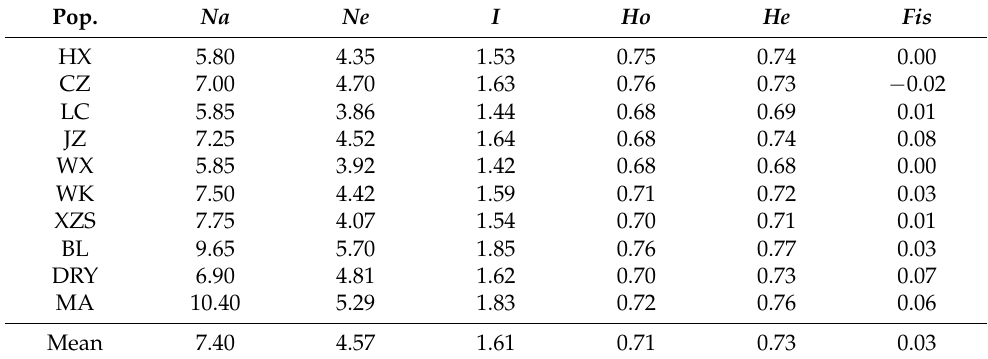
Table 3. The genetic characteristics of the 10 carp populations based on 20 microsatellite